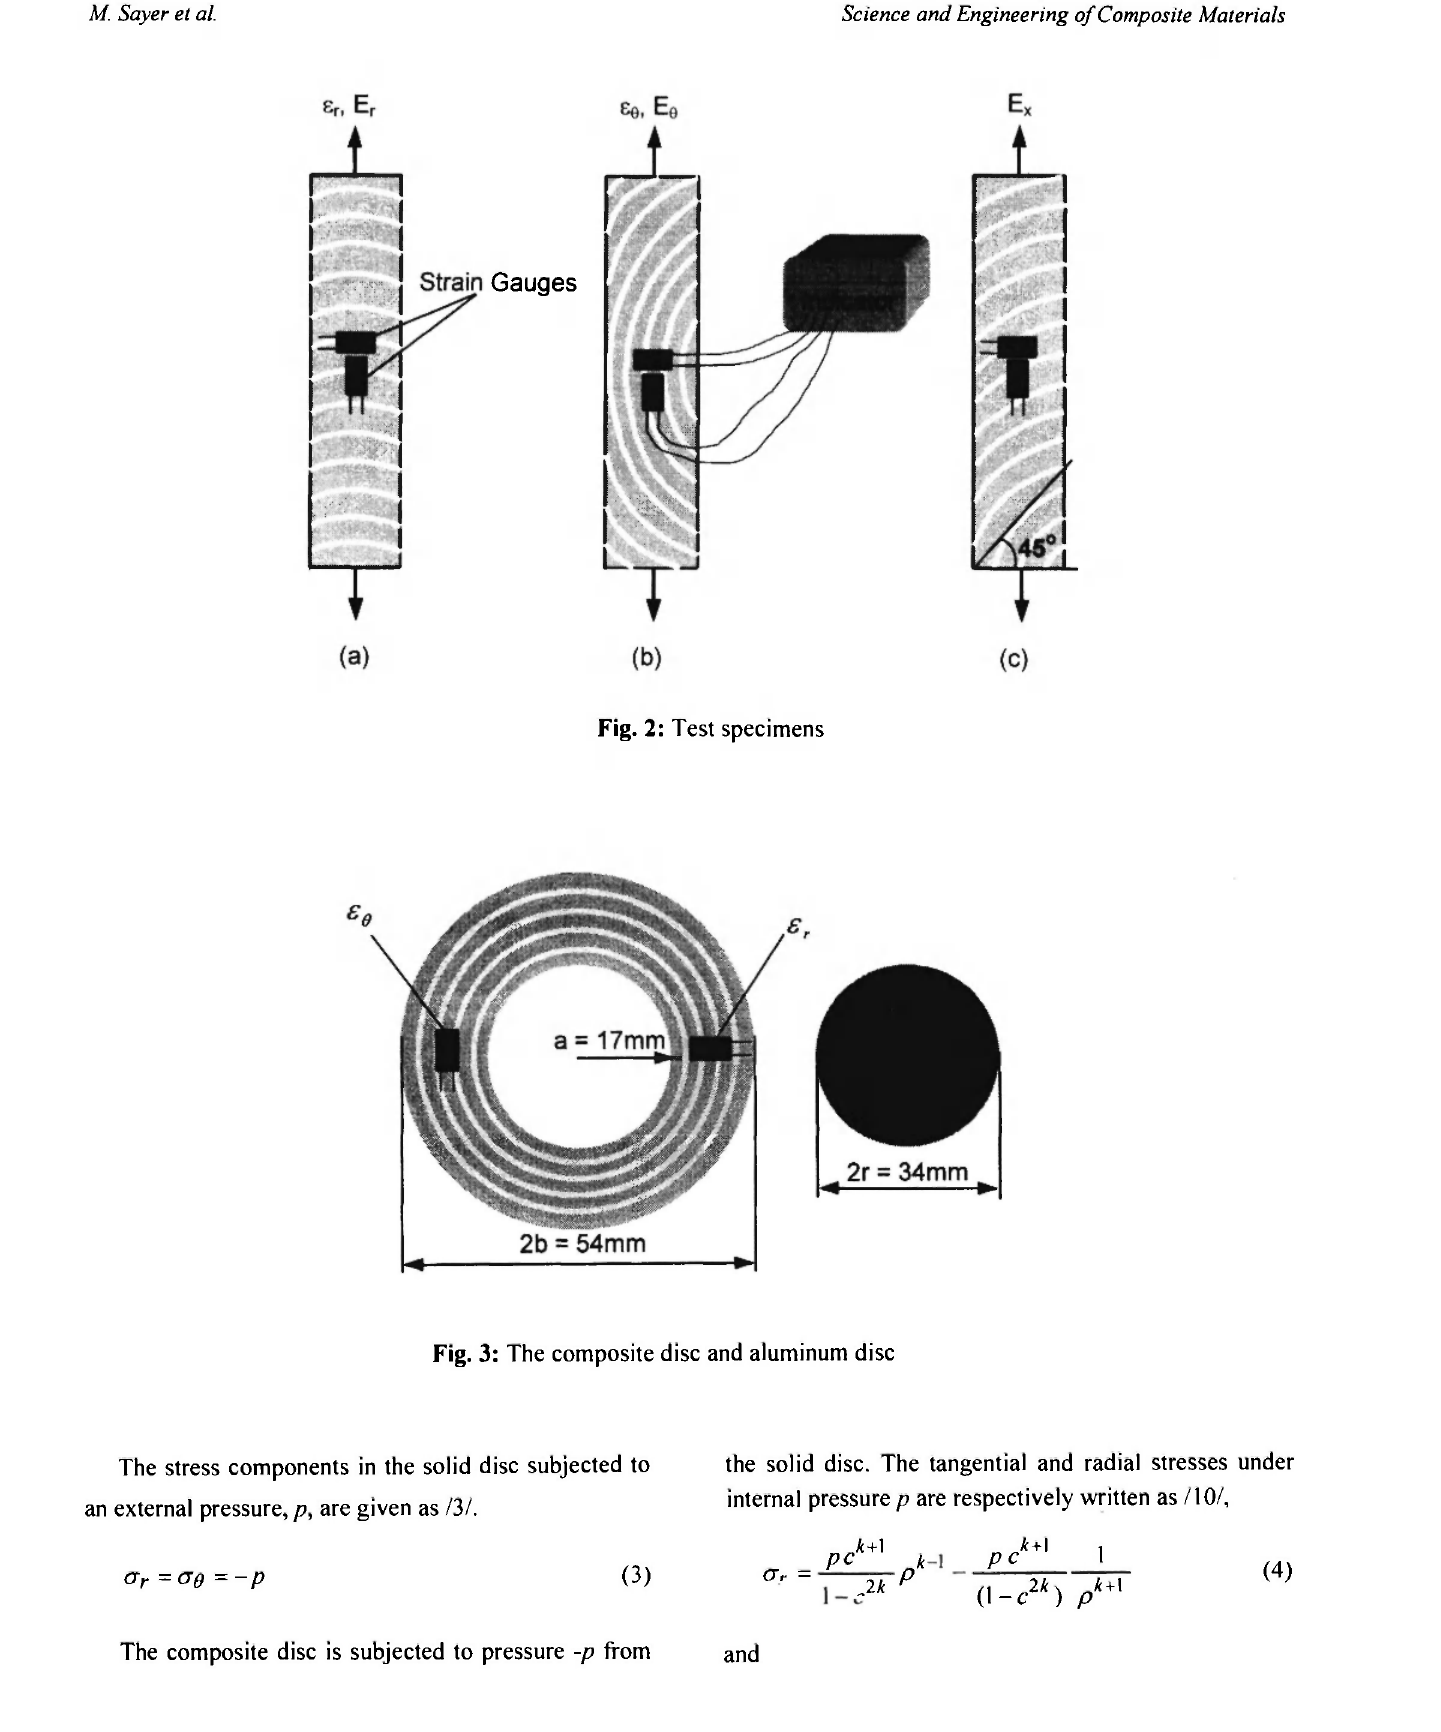
Fig. 3: The composite disc and aluminum